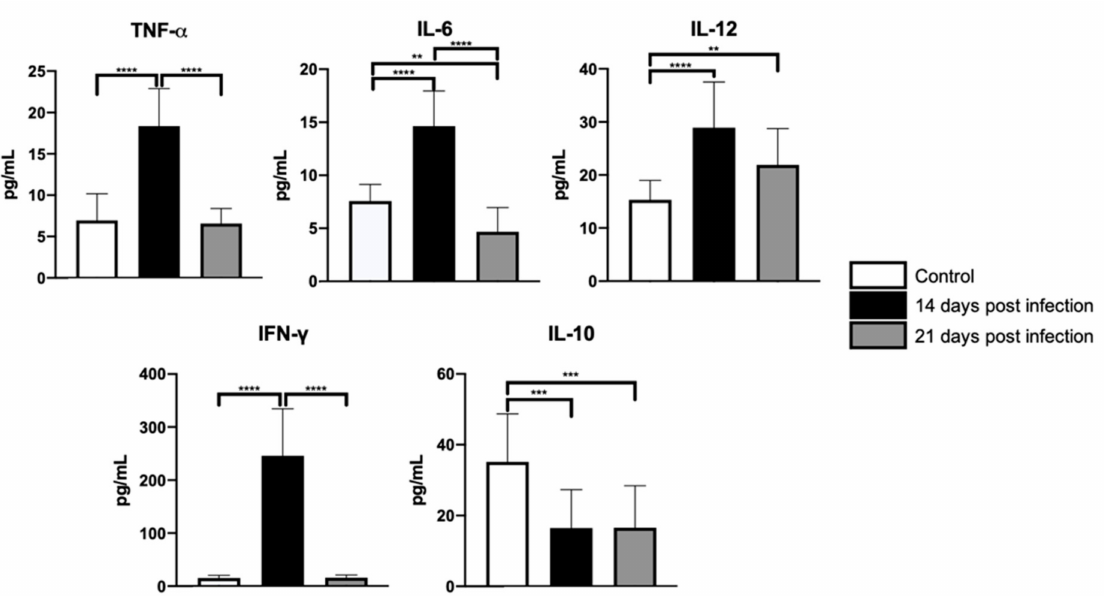
Figure 5. Inflammatory profile in infected Balb/c mice. A transiently exacerbated inflammatory response was documented in infected mice when compared with control mice at day 14 -PI. After this time point, the intensity of inflammatory response falls significantly by day 21-PI. Kruskal–Wallis tests were used in all cases, except for IFN- γ , in which ANOVA tests were used. Statistical significance was recognized when p < 0.05. Statistical significance is represented as follow: